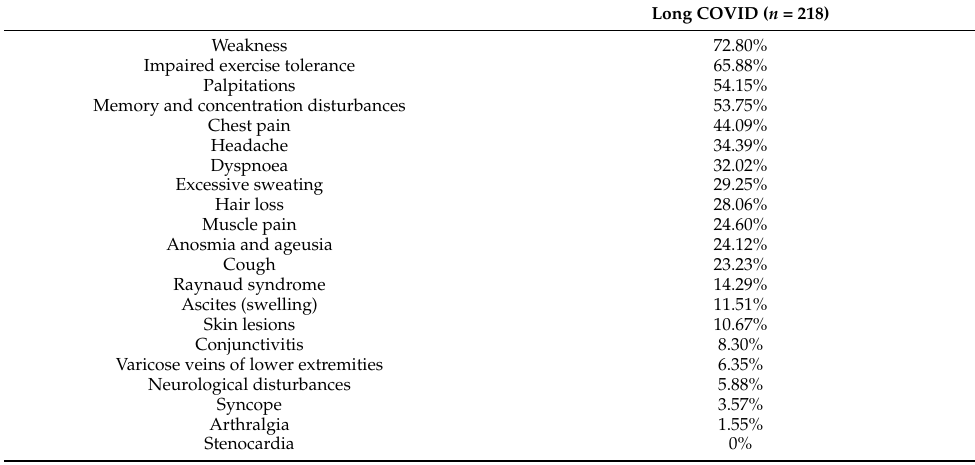
Table 3. The assessment of symptoms in LC group.